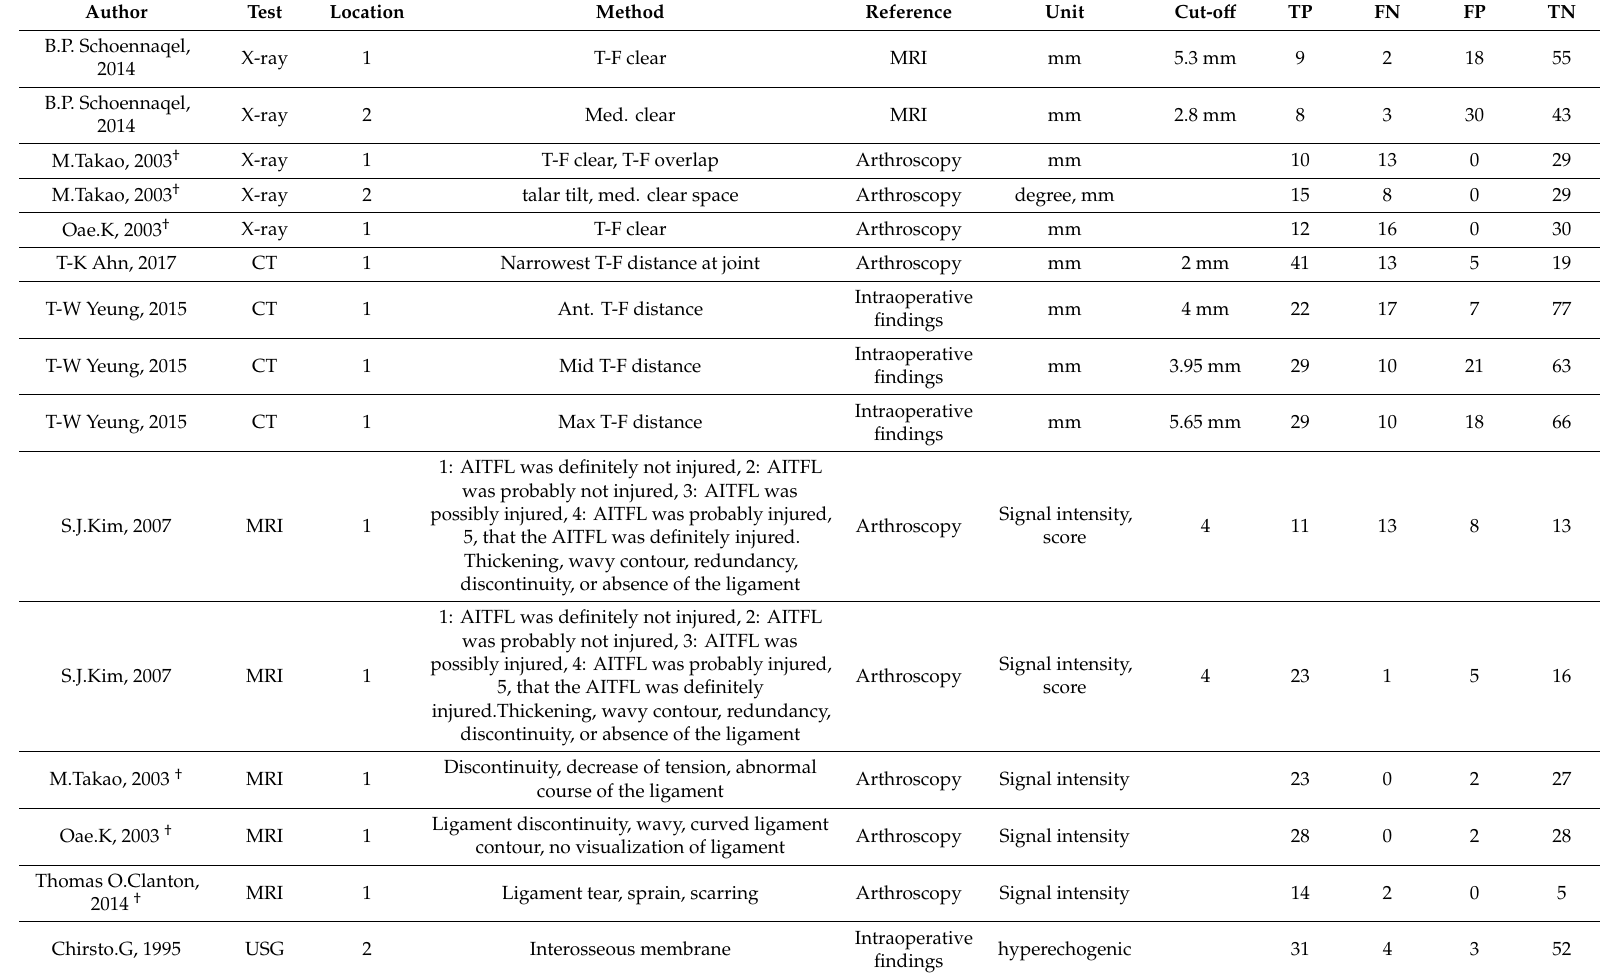
Table 3. Detailed outcomes and diagnostic accuracy findings of included